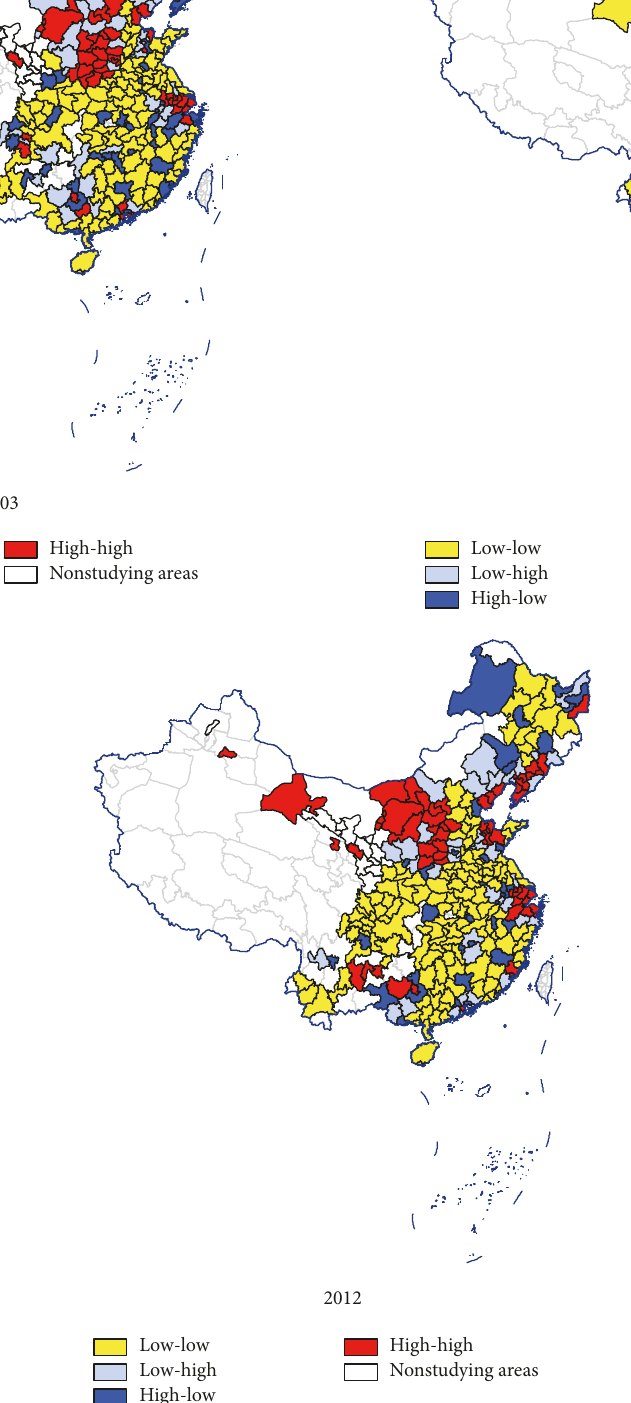
Figure 3: LISA maps of environmental pollution